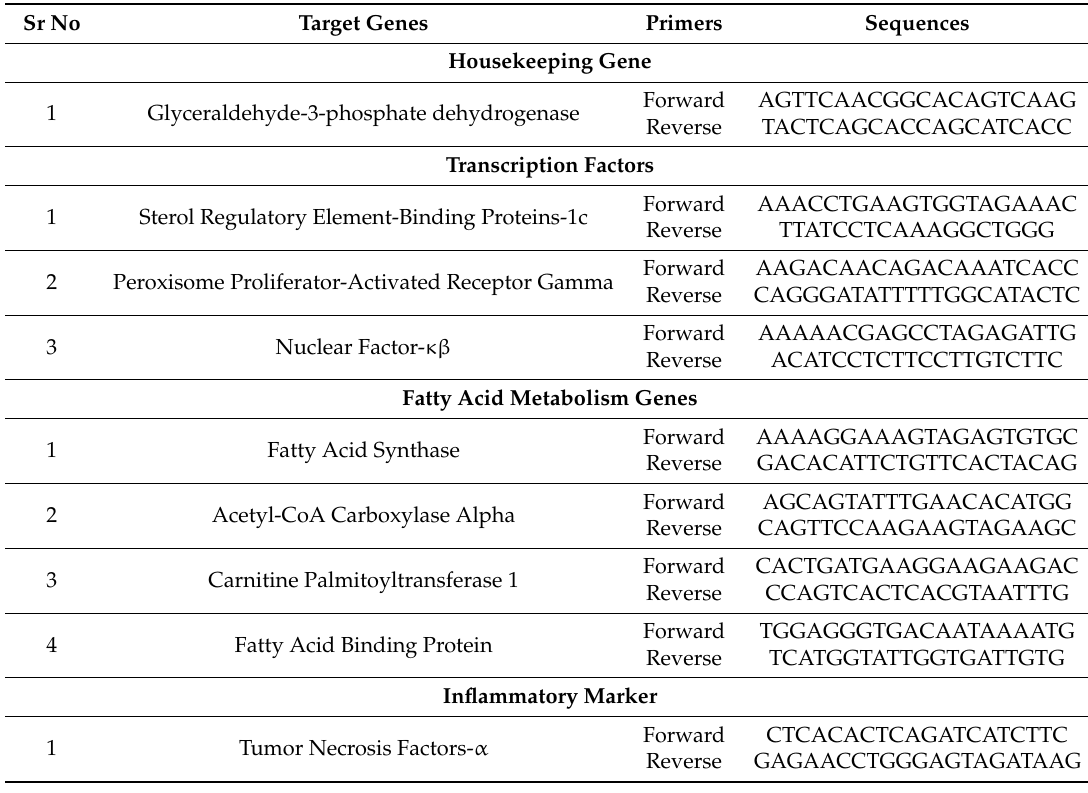
Table 2. The selected genes and their primer